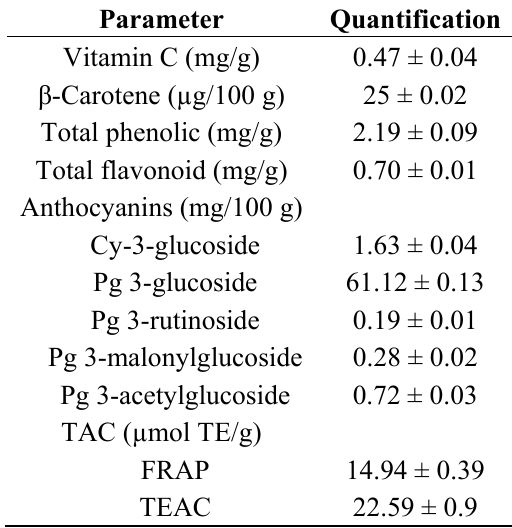
Table 1. Nutrient composition, phytochemical content and antioxidant capacity of strawberry